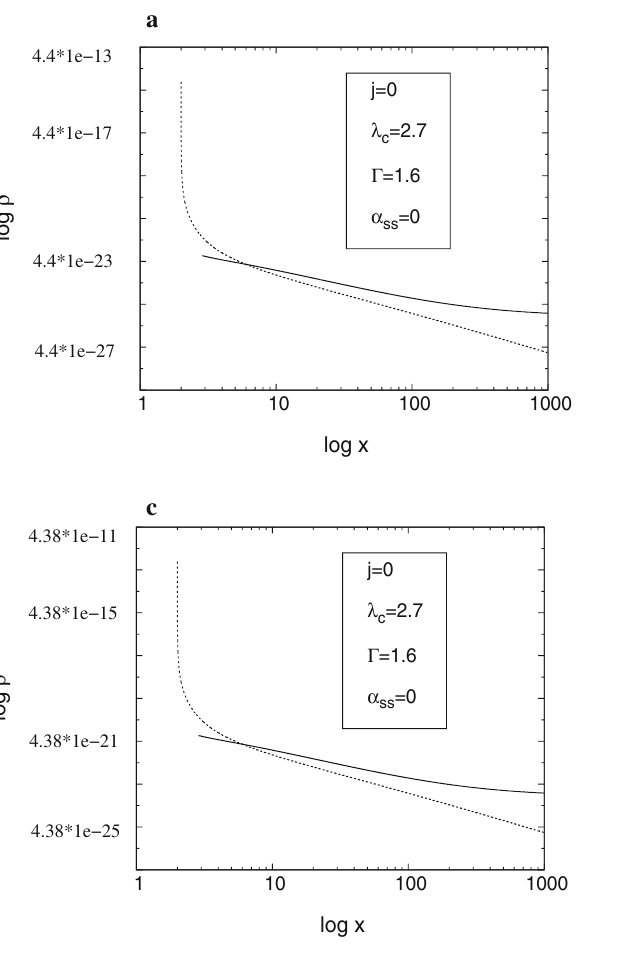
Fig. 2 a , c Plotsof log (ρ) vs log ( x ) fornonviscous accretiondiscflow around a non-rotating BH for adiabatic case using NFW and Einasto profile respevctively. b , d Plots of log (ρ) vs log ( x ) for nonviscous